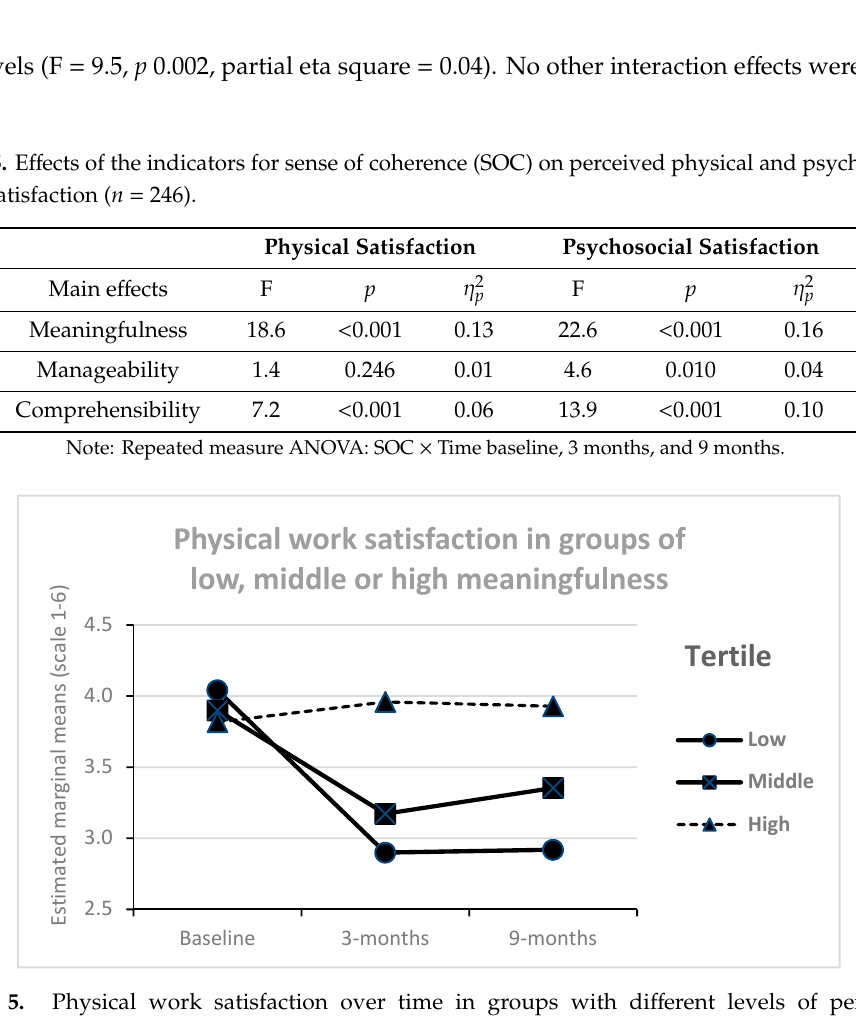
Table 5. Effects of the indicators for sense of coherence (SOC) on perceived physical and psychosocial work satisfaction ( n = 246).